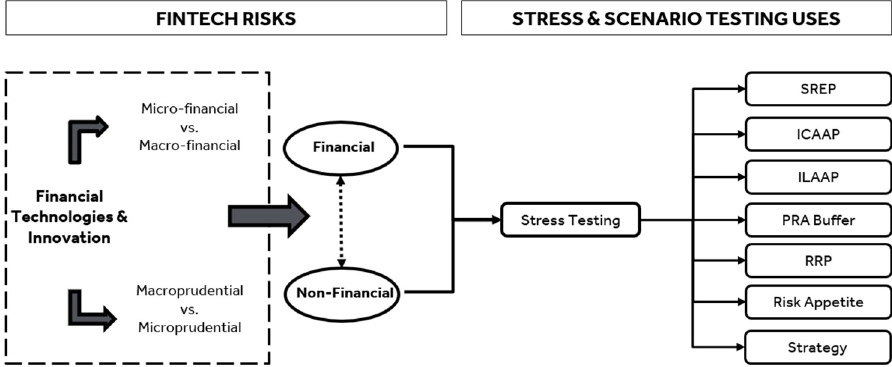
Figure 3. Fintech risks and stress testing uses.